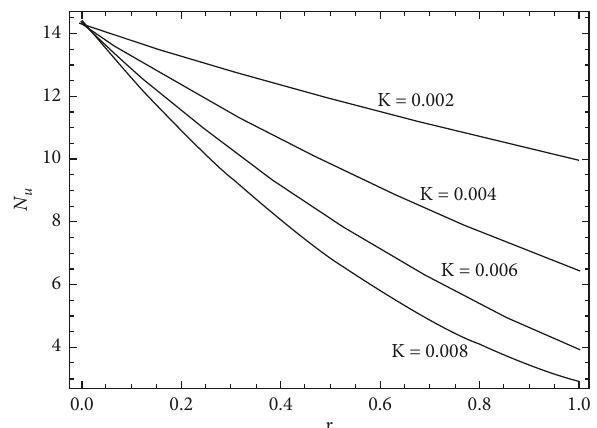
Figure 14: Variation of θ with r for different values of B P 0 � 43, z � 0.1, We 2 � 0.0001, K � 0.001, n �− 1, and m � 0.5.